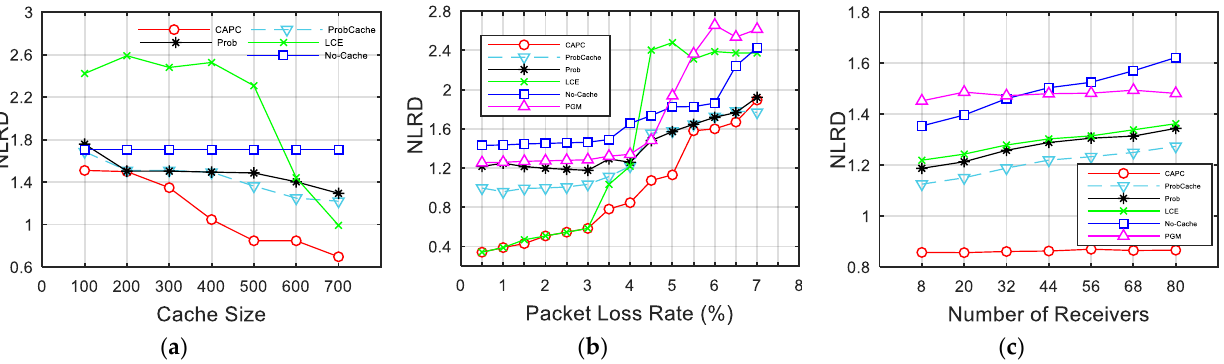
Figure 7. The comparison of normalized loss recovery delay (NLRD). ( a ) The comparison of NLRD under different cache sizes; ( b ) the comparison of NLRD under different packet loss rates; ( c ) the comparison of NLRD under different numbers of receivers.